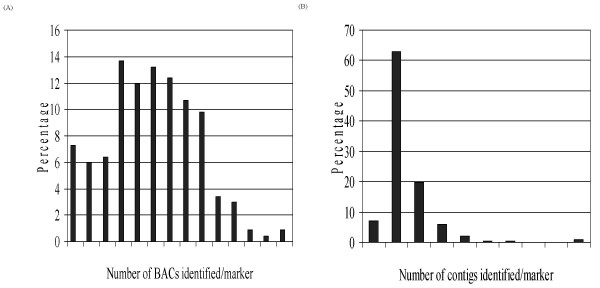
Distribution of BAC, Contig/marker hits. Maize HindIII BAC pools (6×) were screened with 237 PCR-base STS markers. The distribution of BAC hits/marker using all 237 markers (A) is illustrated. Among 237 markers tested, marker and BAC association data from 197 markers, and map position on the IBM genetic map, were used for the analysis of distribution of the numbers of identified contigs for each marker (B).